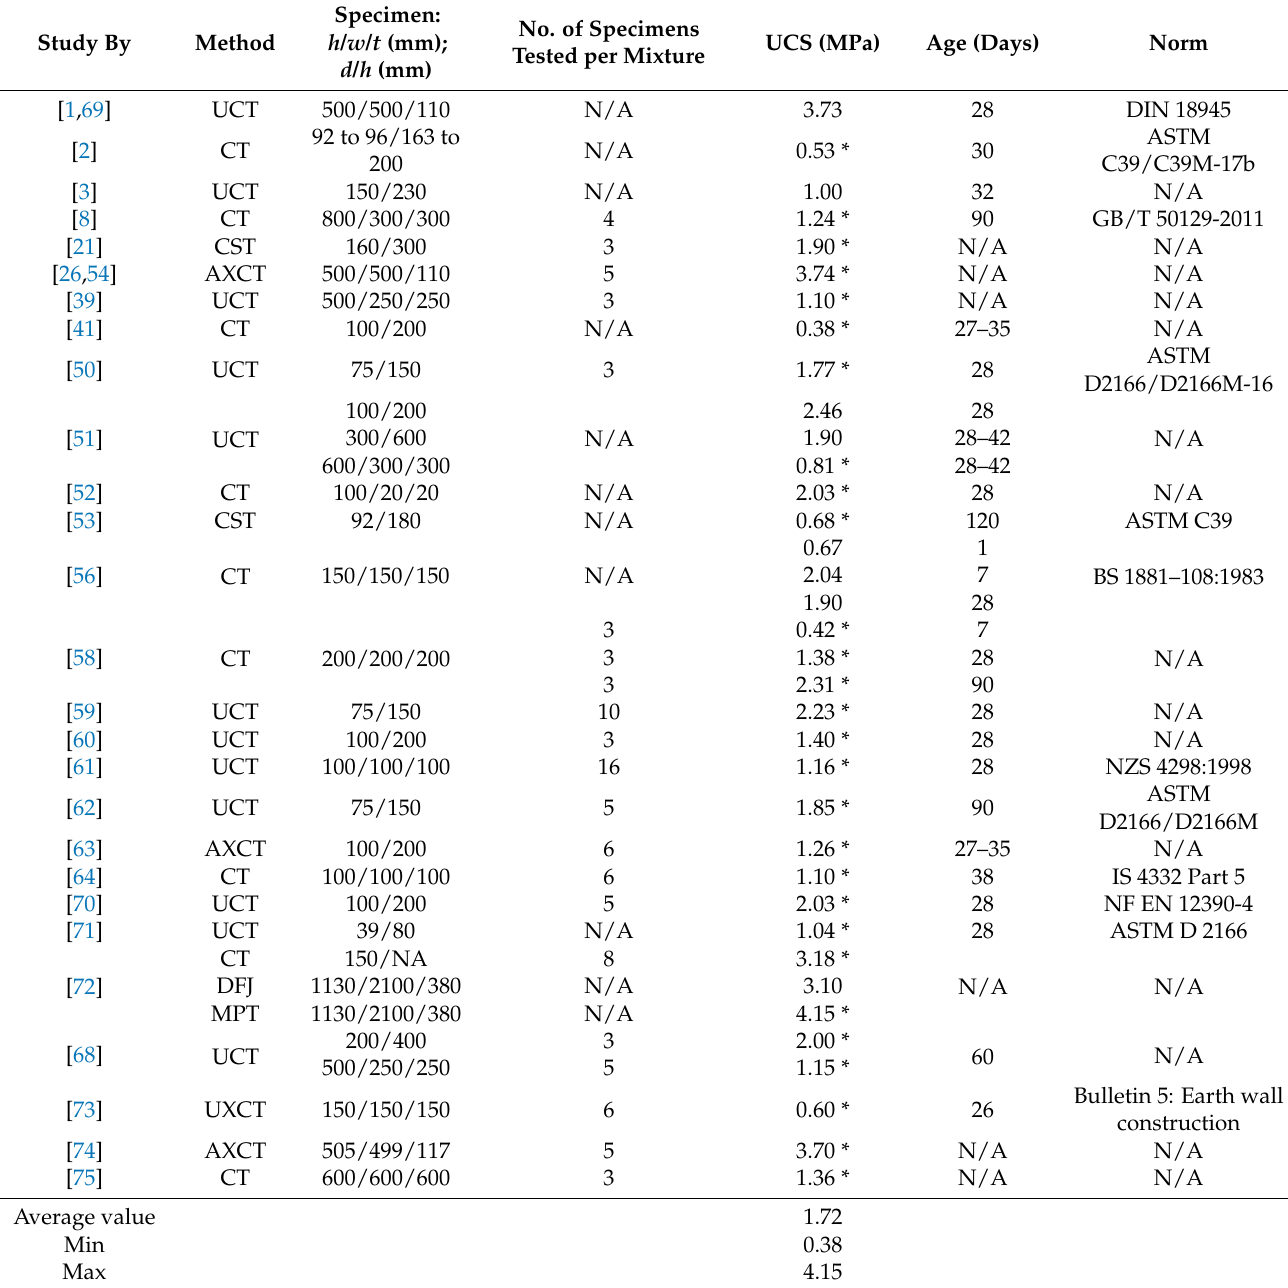
Table 3. UCS values obtained at different age, along with description of methods, specimens, and norms employed.